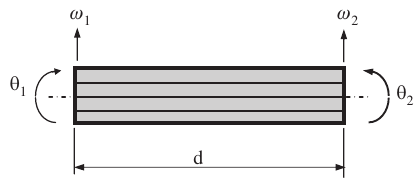
Figure 3 Elemental length of the